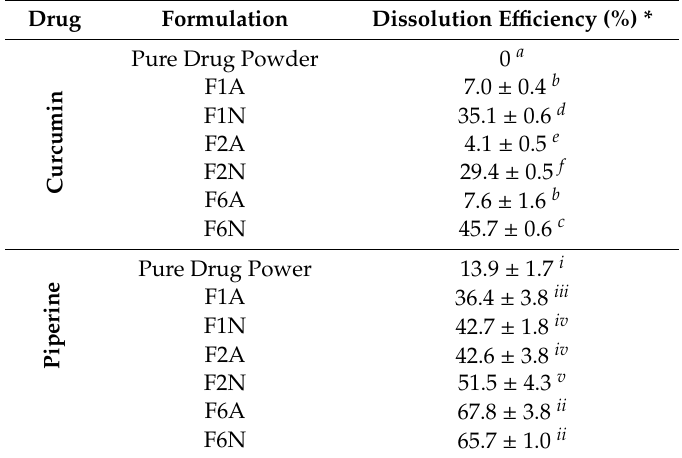
Table 4. Dissolution efficiency of the representative formulations comprising CUR and PP.